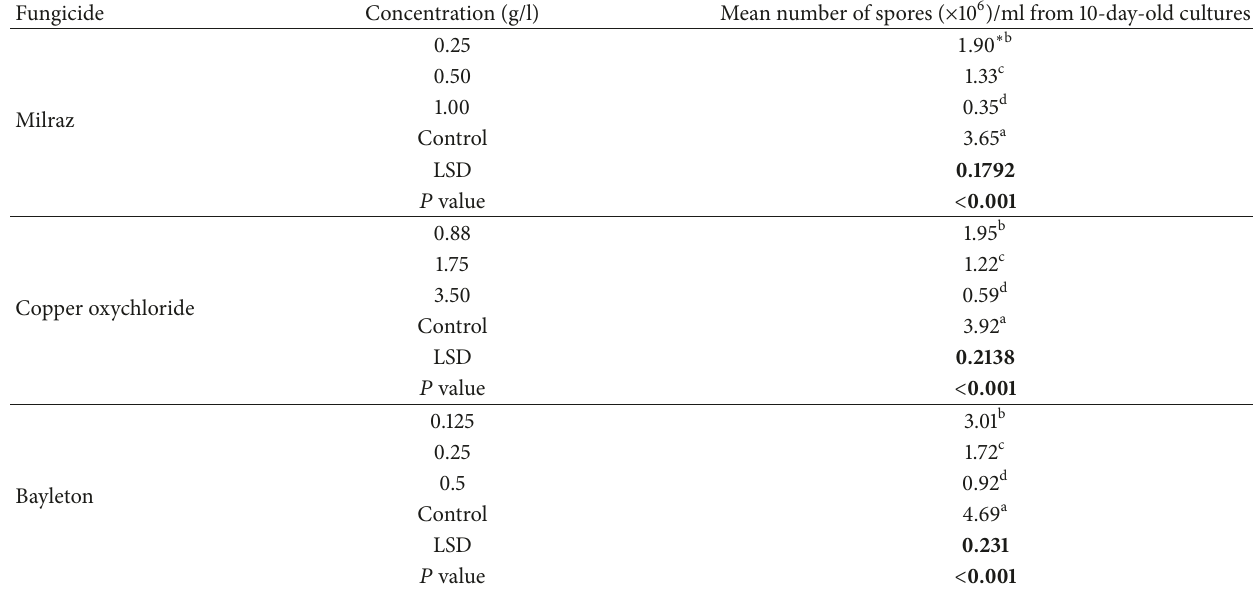
Table 4: Effect of selected fungicides on C. gloeosporioides